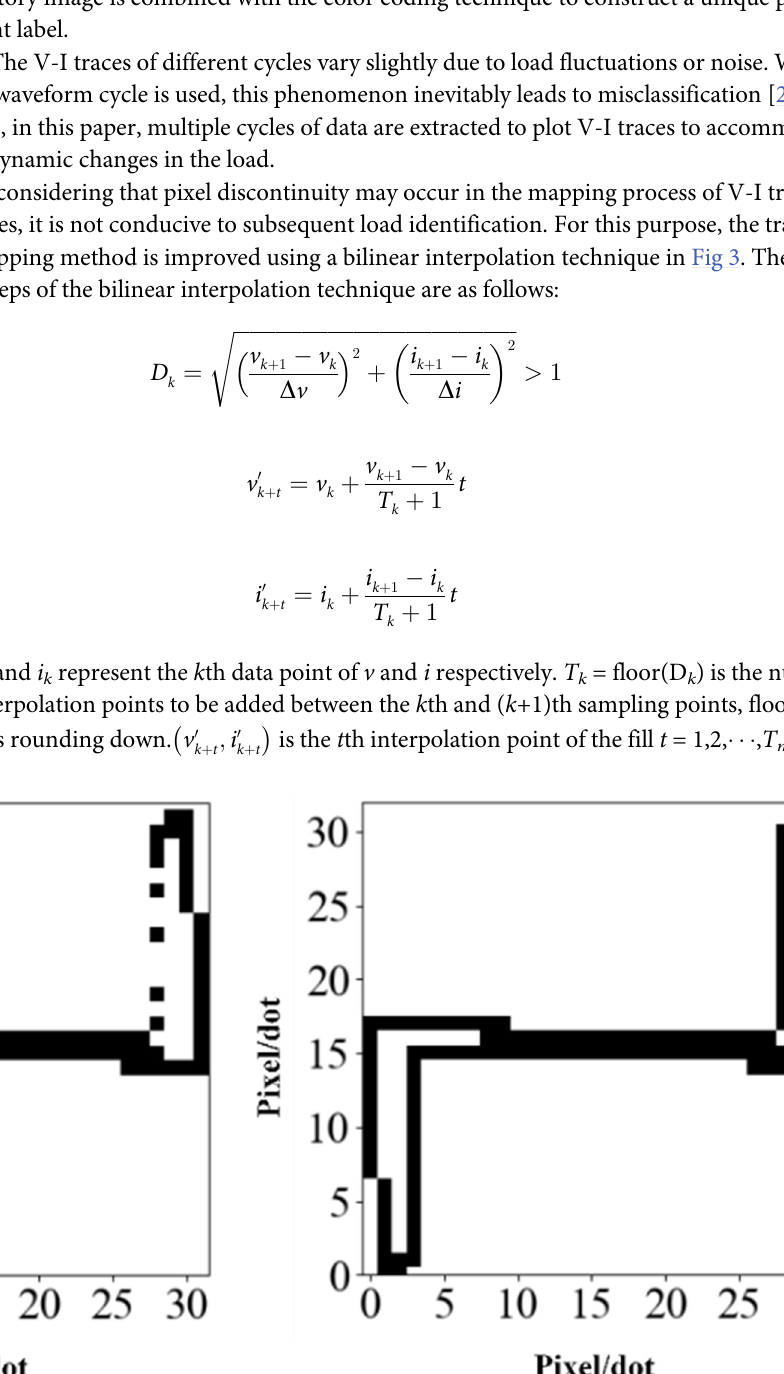
PLOS ONE | https://doi.org/10.1371/journal.pone.0281482 February 9,